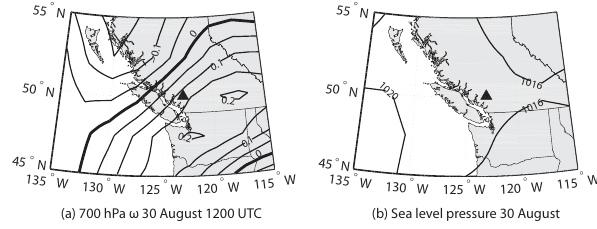
Fig. 3. NCEP reanalysis data from 30 August 2009 showing: (A) the 700hPa vertical motion field (Pa s − 1 ) at 12:00 UTC/04:00 LST, with downward motion indicated by positive ω values southeast of the bolded zero contour, and (B) the averaged sea level pressure (hPa) pattern for the LST day.